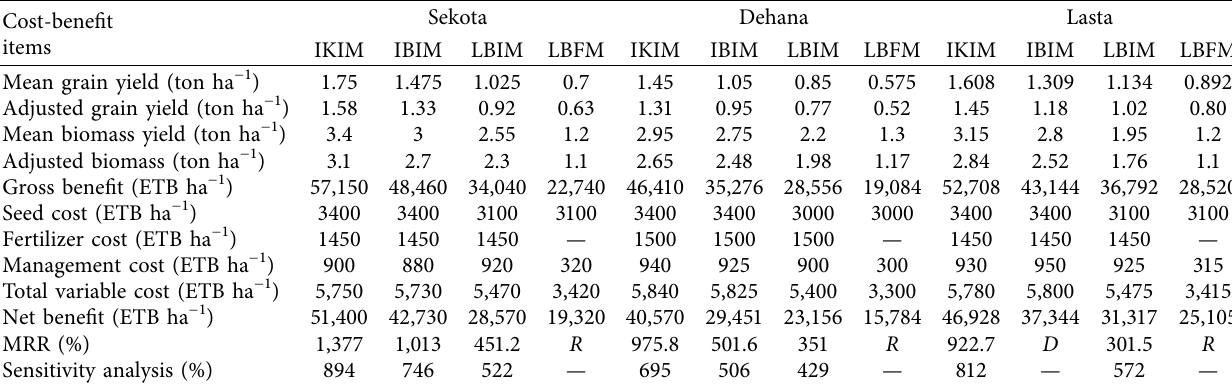
Table 4: Partial budget analysis and proftability of experimental treatments across districts.